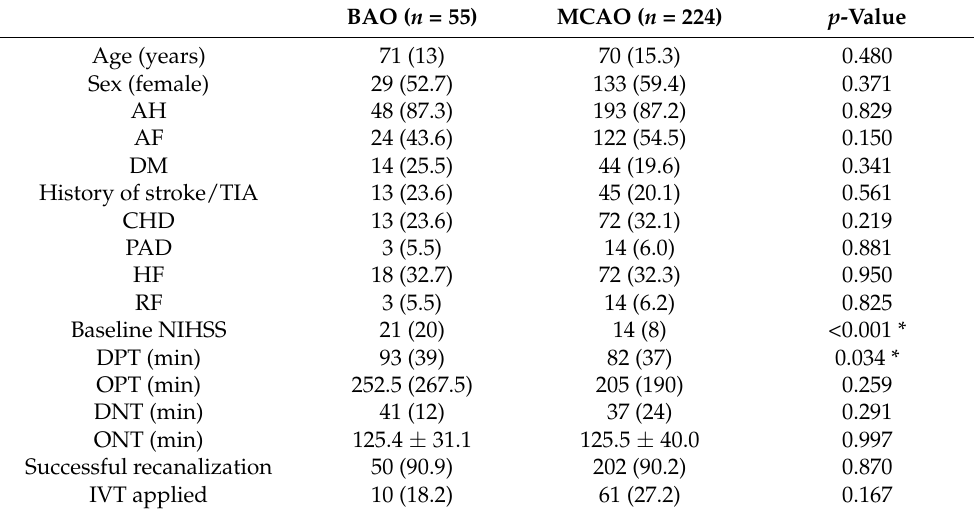
Table 1. Baseline characteristics of the study population in BAO and MCAO groups.